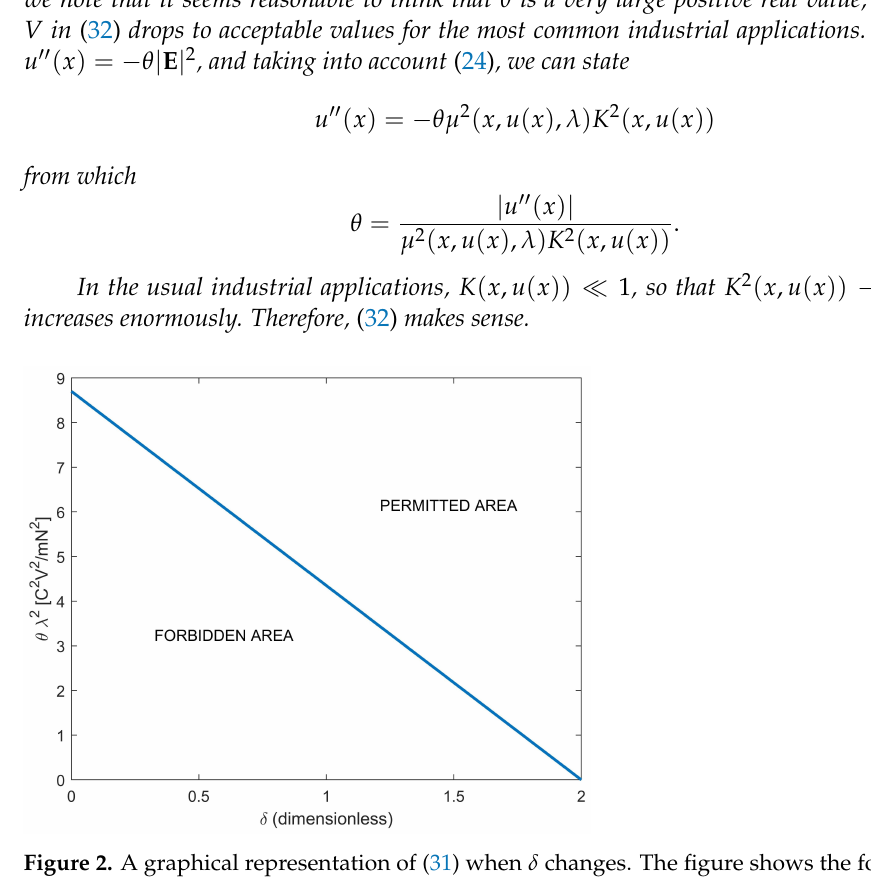
Figure 2. A graphical representation of (31) when δ changes. The figure shows the forbidden area and that allowed as regards the values of θλ 2